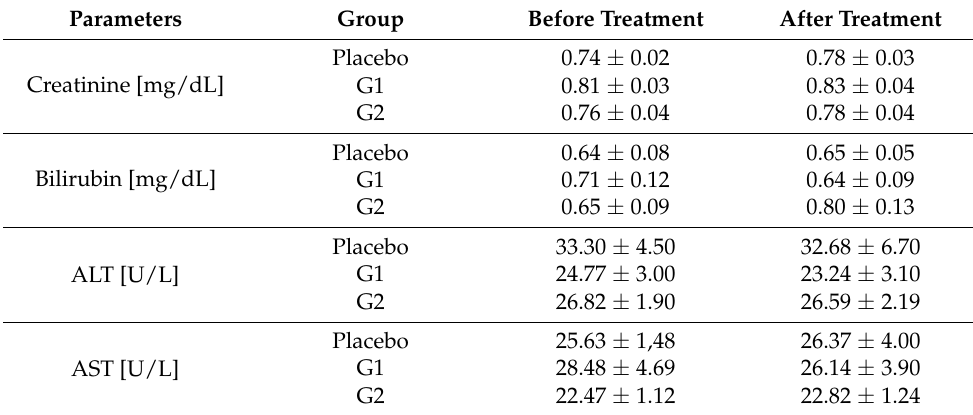
Table 3. Blood serum biochemical parameters of study population (mean ± SEM).